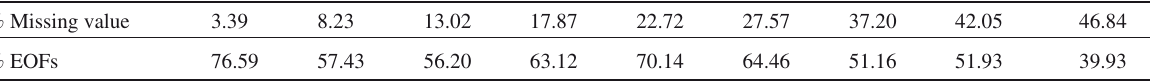
Fig . 5. – A, Root Mean Square Error (RMSE); and B, Mean Absolute Deviation (MAD). Table 2. – Variance explained using EOF with different percentages of missing values.